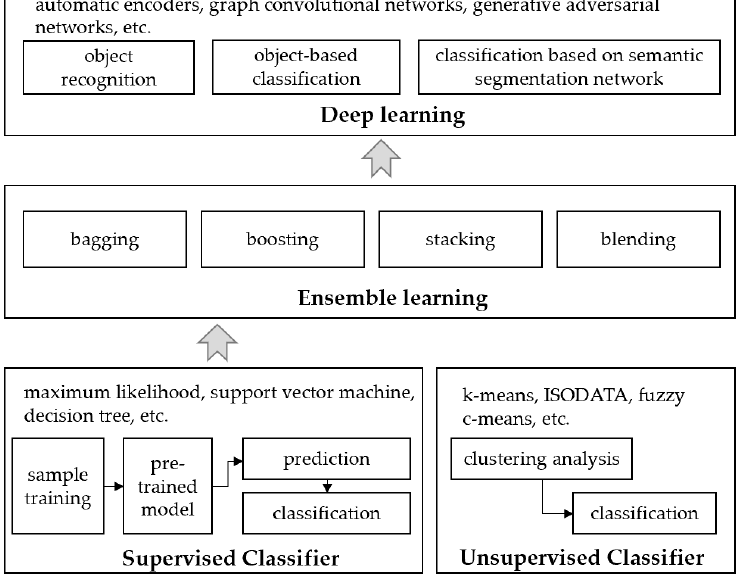
Figure 6. Development of feature learning